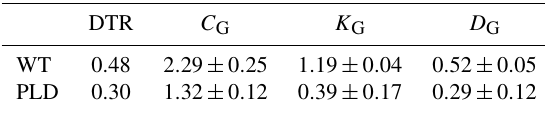
Table 2. Measurements of ice table depth as depth to re- fusal DTR (m) and soil thermal properties close to the surface: soil volumetric heat capacity C G (MJm − 3 K − 1 ), thermal con- mean ± standard deviation. Measurements were taken for WT (wa- ter track) and PLD (paleolake